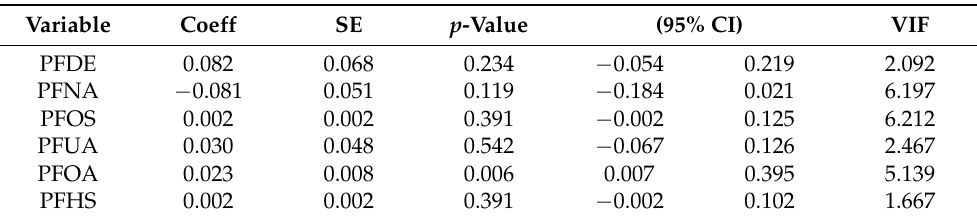
Table 5. Association between AL and individual PFASs of interest (unadjusted models) and variance inflation factor (VIF) values for each PFAS.